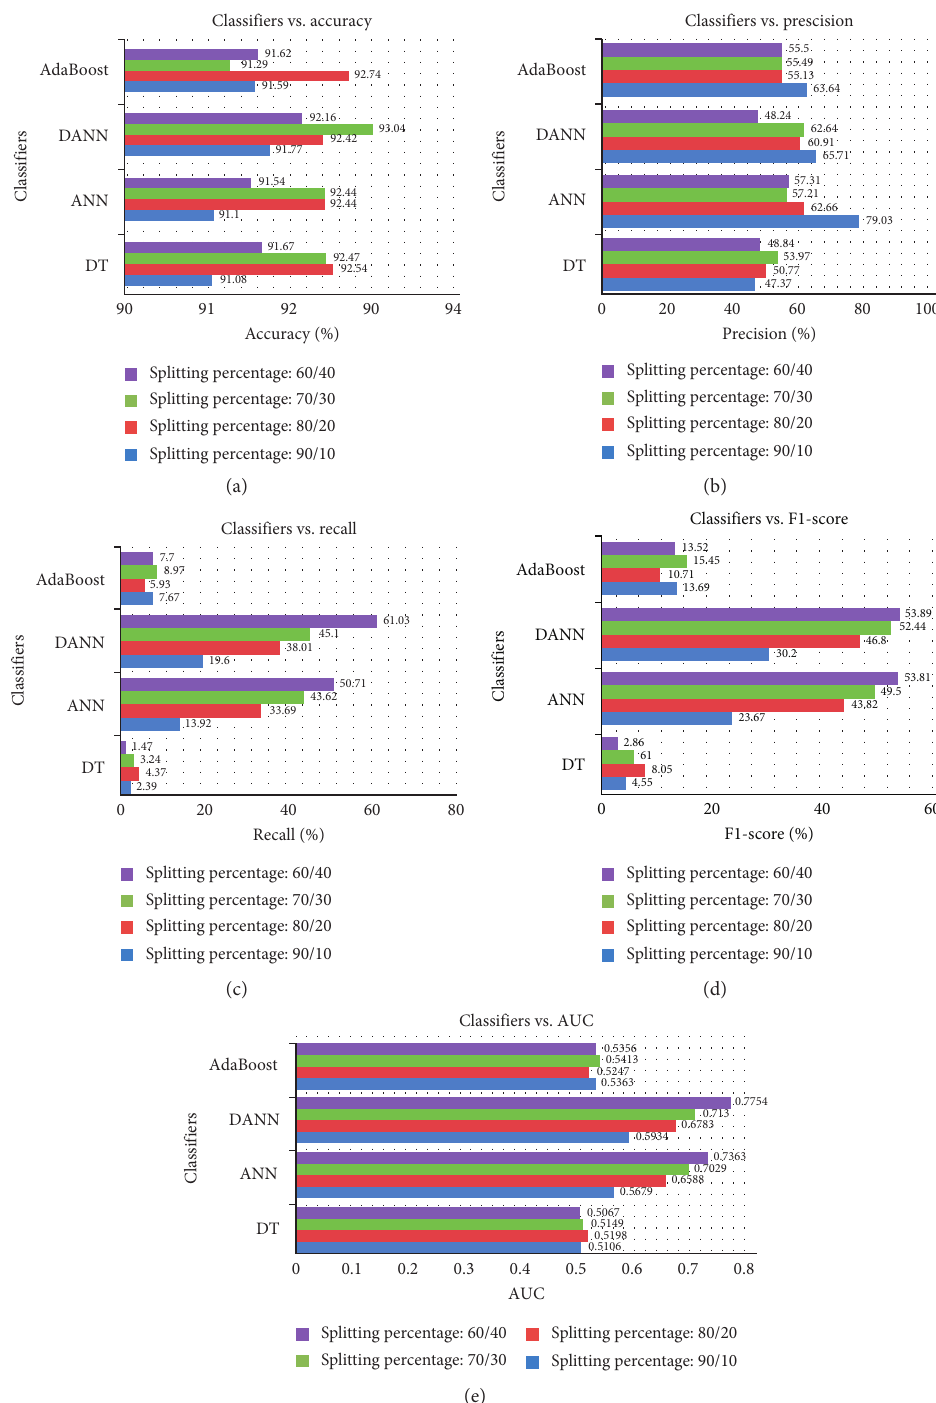
Figure 6: Pattern of evaluation methods such as (a) accuracy, (b) precision, (c) recall, (d) F1-score, and (e) AUC for each